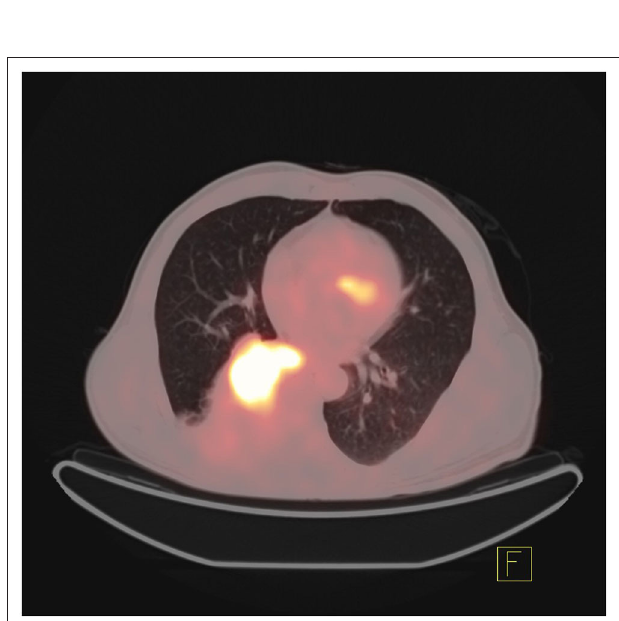
FIGURE 5 | PET/CT manifestations of EGFR wild-type patients with lung